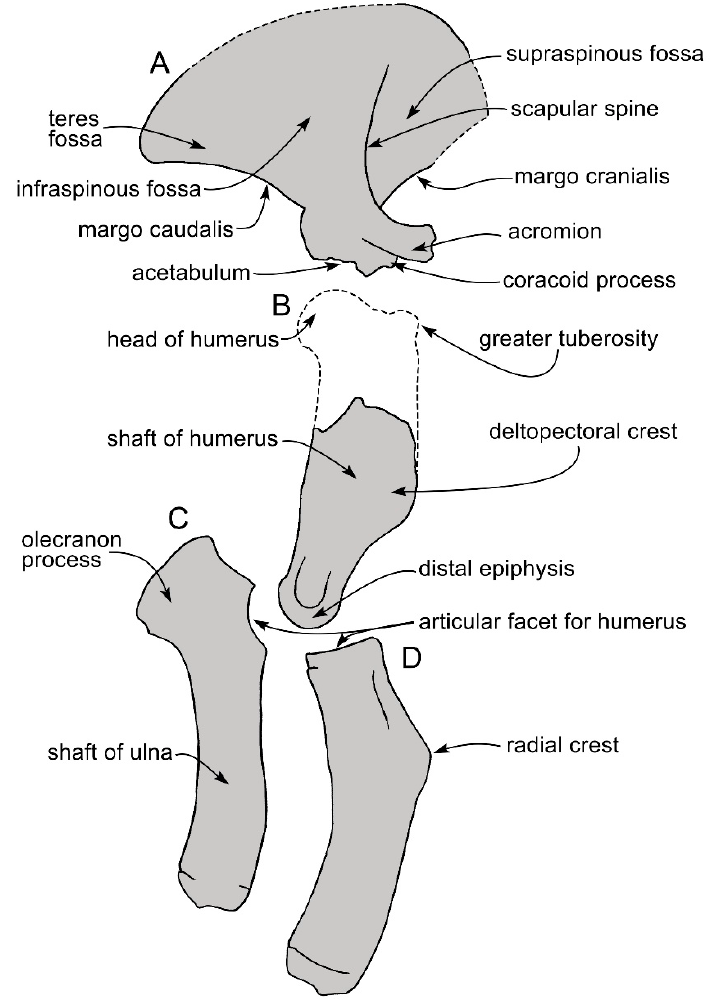
Figure 4. Schematic representation of the appendicular skeleton of Zygorhiza kochii (United States National Museum, Smithsonian Institution No. 4673; specimen mirrored in the present figure) in lateral view showing characters discussed in the text. ( A ) Scapula. ( B ) Humerus. ( C ) Ulna. ( D ) Radius. Not to scale.